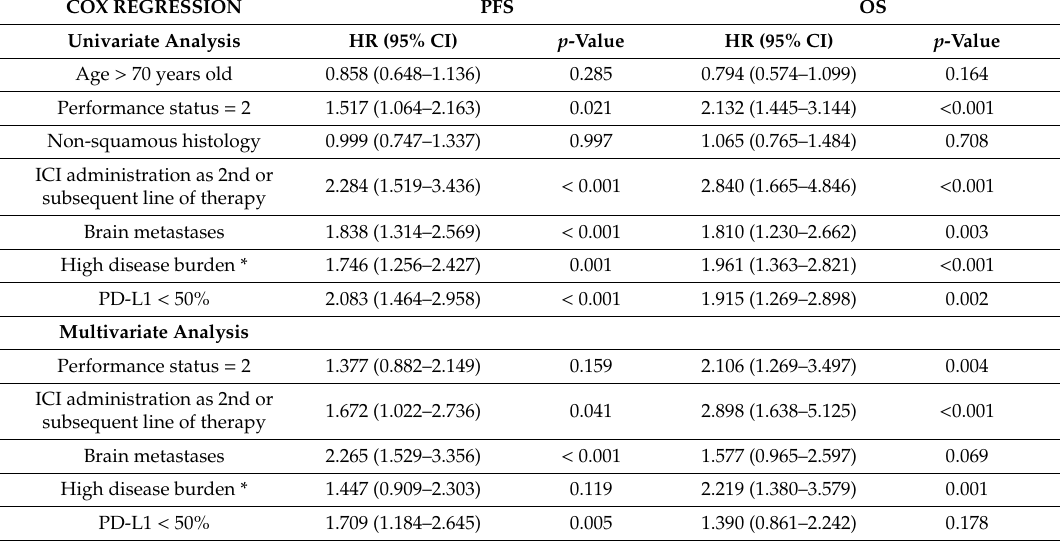
Table 3. Univariate and multivariate analysis using the Cox regression method to evaluate the e ff ect of various parameters on survival outcome in the whole patient population ( n =